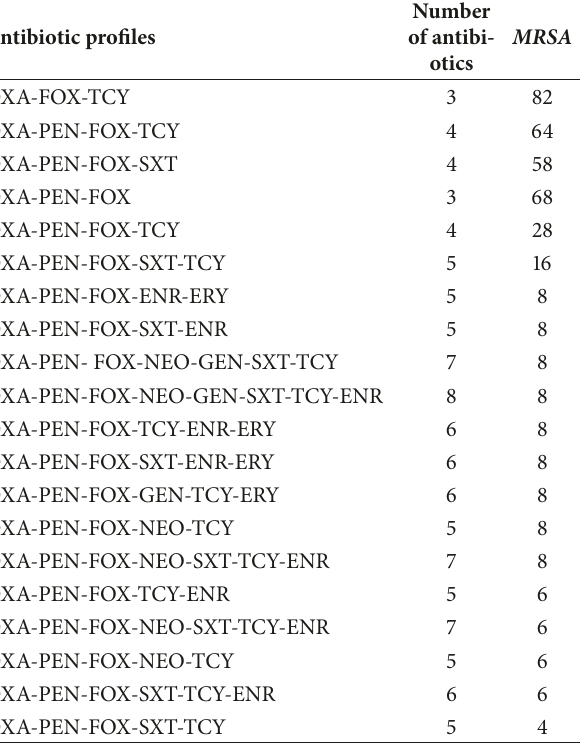
Table 4: Antibiotic resistance patterns of MRSA in hens (n=448). Resistance patterns